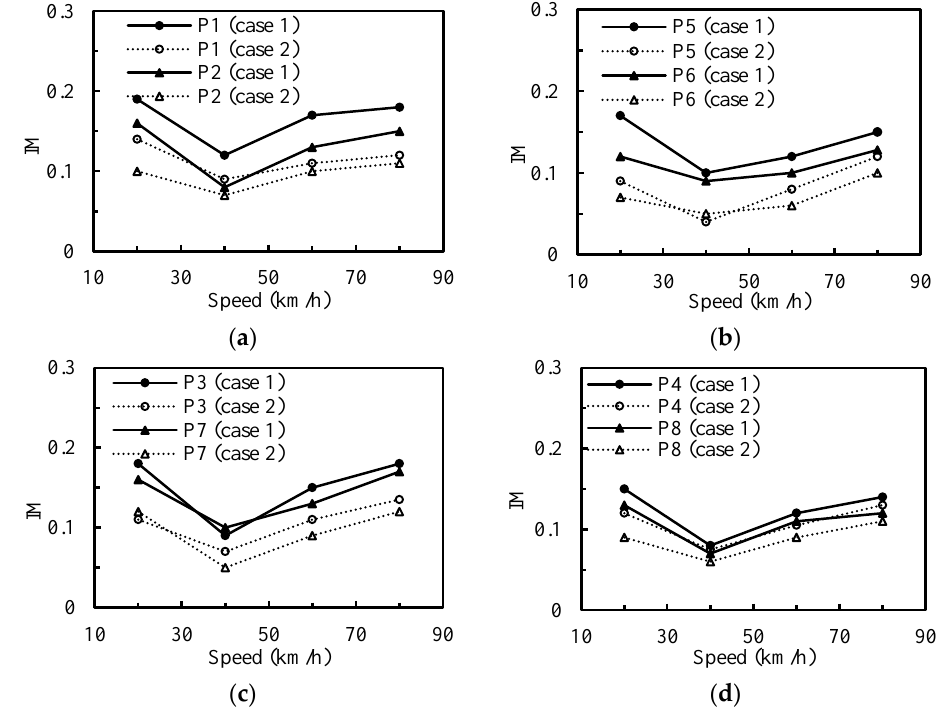
Figure 11. Impact factors calculated from strains of test points: ( a ) P1/P2; ( b ) P5/P6; ( c ) P3/P7; ( d ) P4/P8.